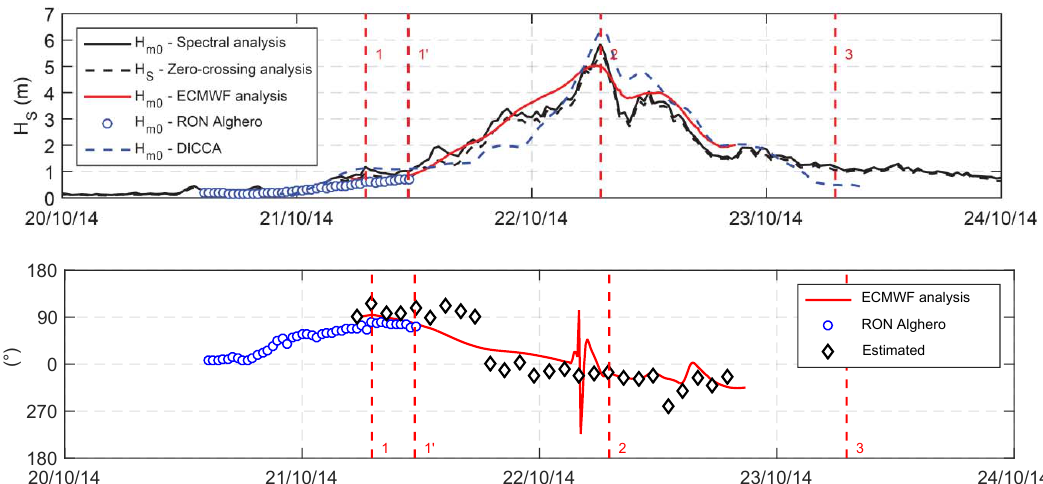
Figure 7. ( Top ) Comparison between the significant wave height measured onboard and the available wave data; and ( Bottom ) comparison between the mean spectral wave direction as estimated by means of the proposed method and the same quantity as obtained by the ECMWF data (red line) and Alghero wave buoy data (blue dots). The red dashed lines refer to four points of interest along the route (as shown in Figure